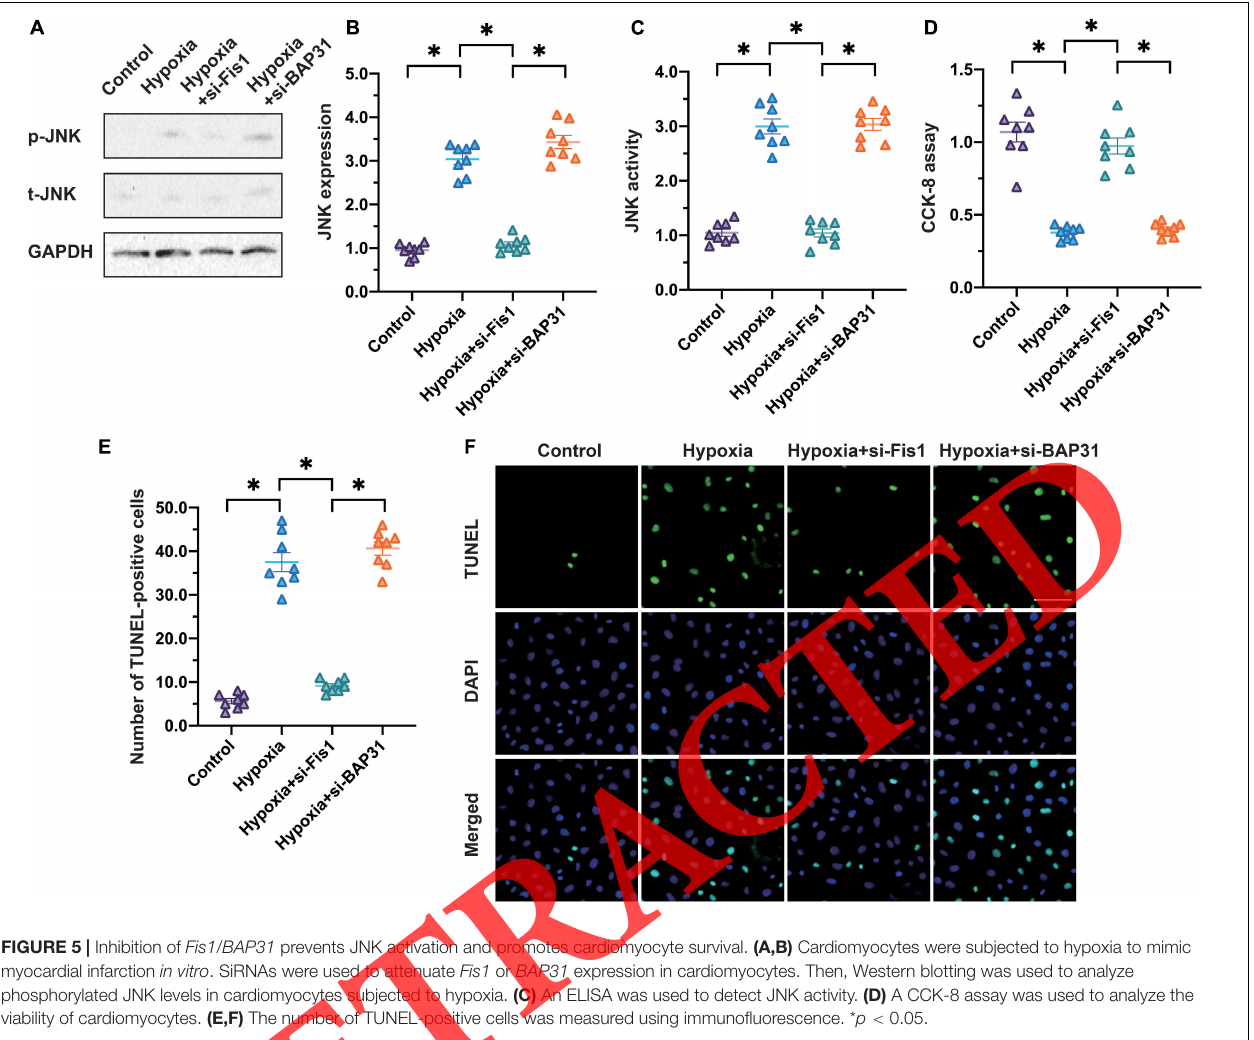
( Figures 5D,E ). The percentage of apoptotic cardiomyocytes was